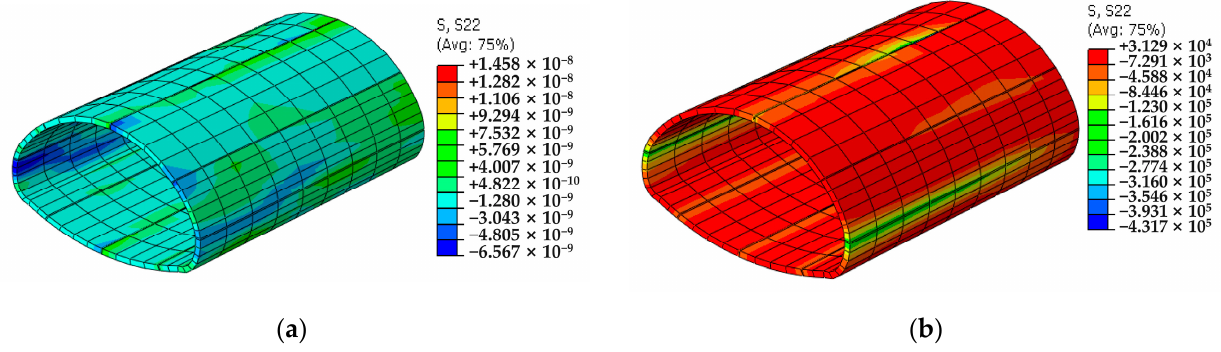
Figure 24. The vertical stress of the secondary lining (unit: Pa): ( a ) Condition 1 and ( b ) Condition 2.